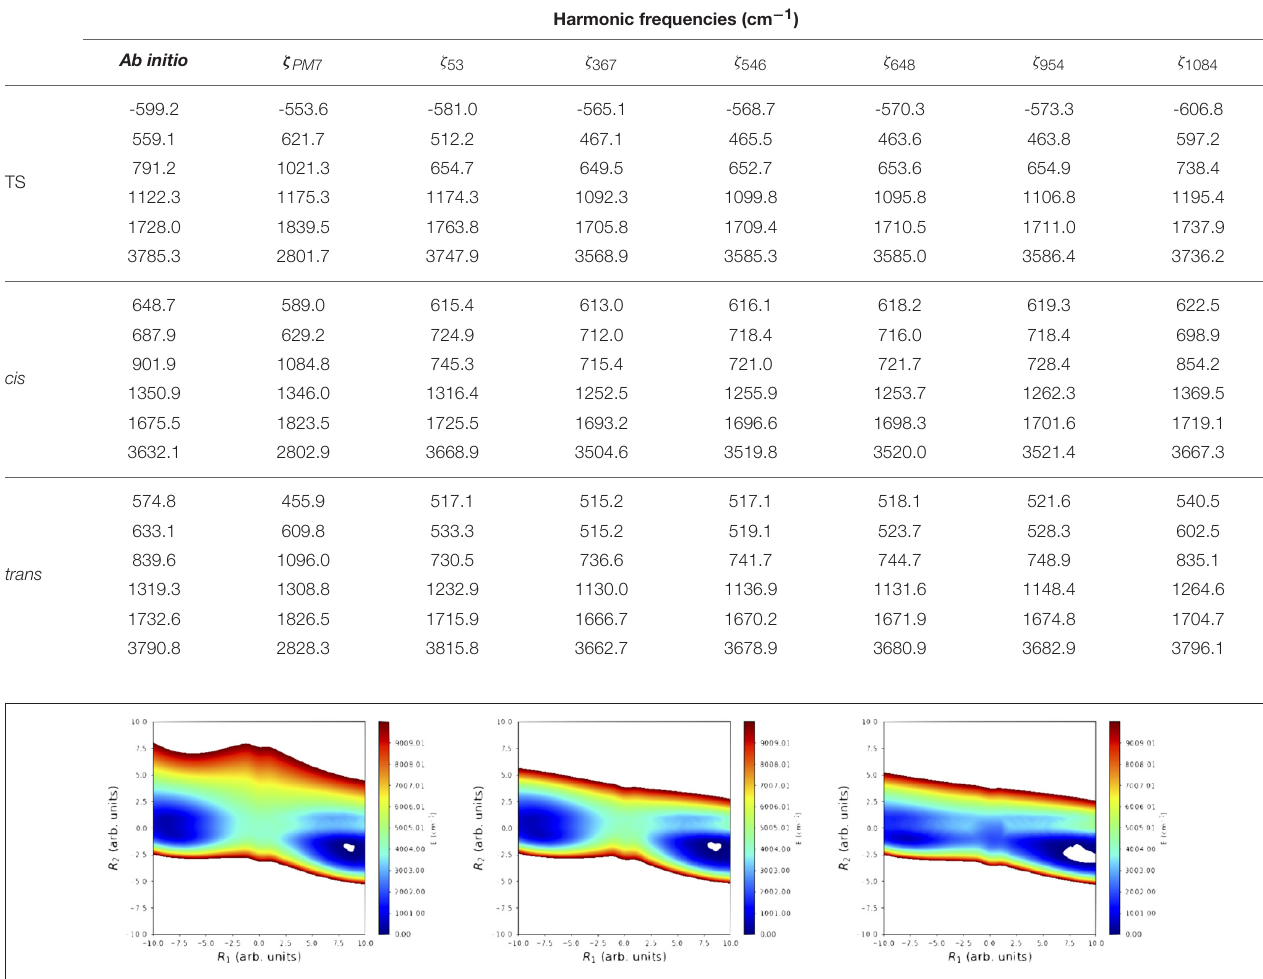
TABLE 2 | Harmonic frequencies of the normal modes of each stationary point at the CCSD(T)/cc-pVQZ ab initio level of theory and corresponding values for the PM7 method and the SRPs in the different stages of the optimization.